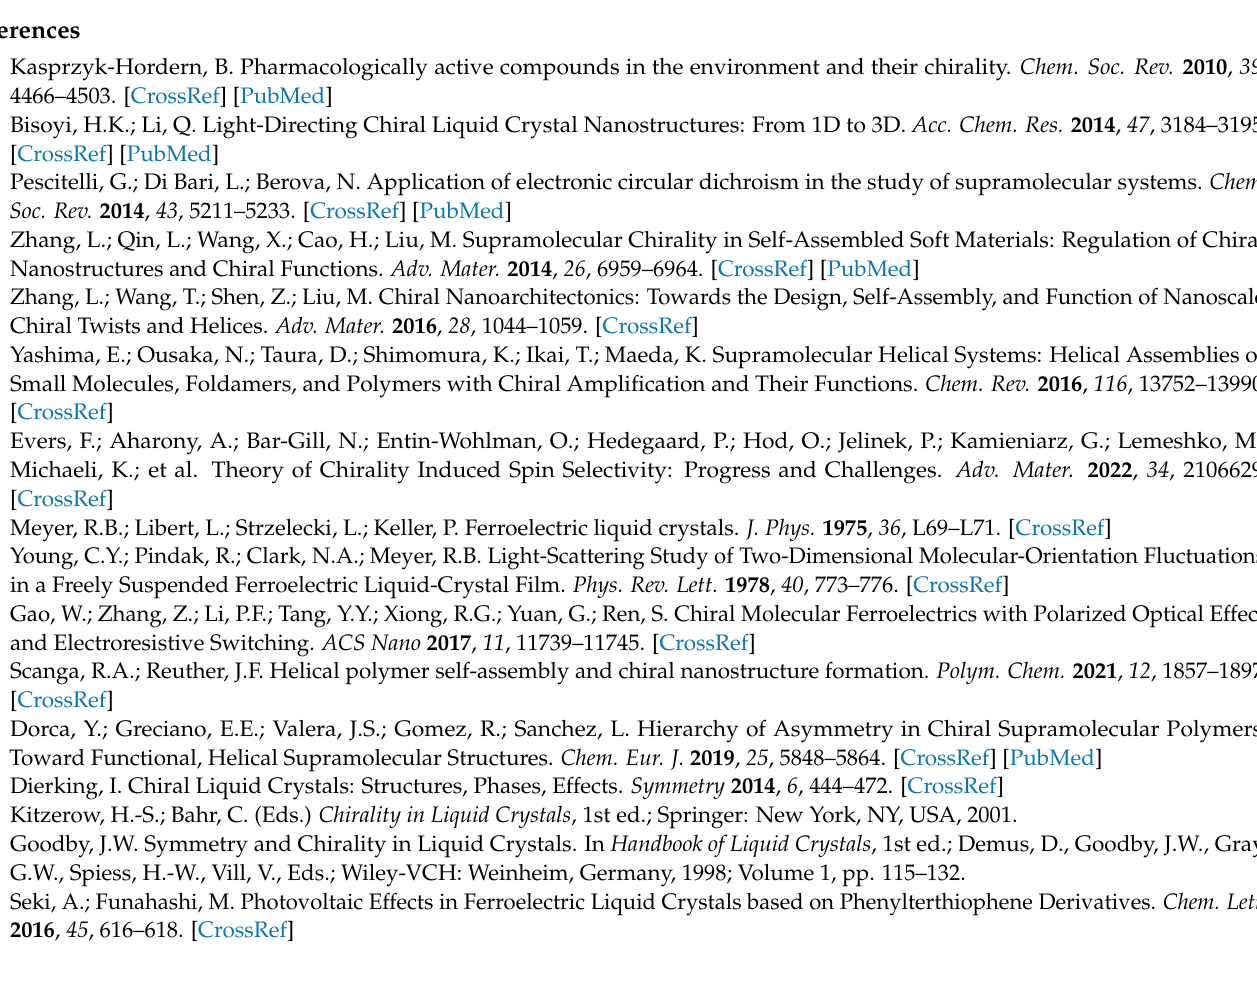
Figure S8. High-resolution ESI mass spectrum of ( R )- 2 ; Figure S9. The high-resolution ESI mass spectrum of ( R )- 3